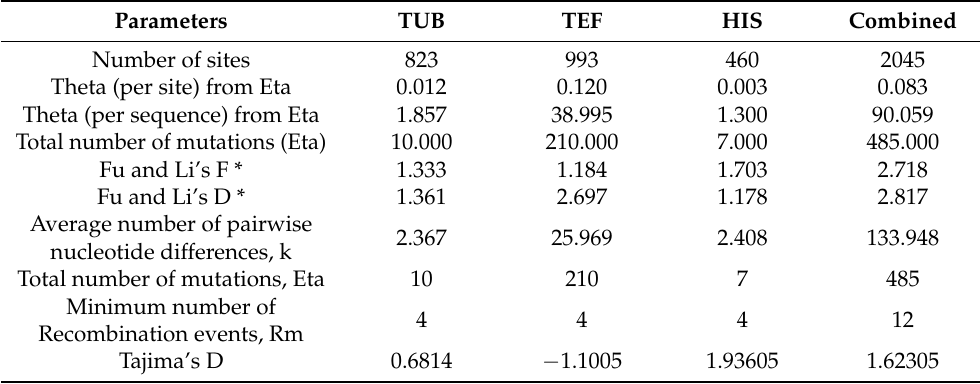
Table 3. DNA polymorphism data for F. graminearum isolates based on tubulin (TUB), translation elongation factor (TEF) and histone (HIS) gene sequence